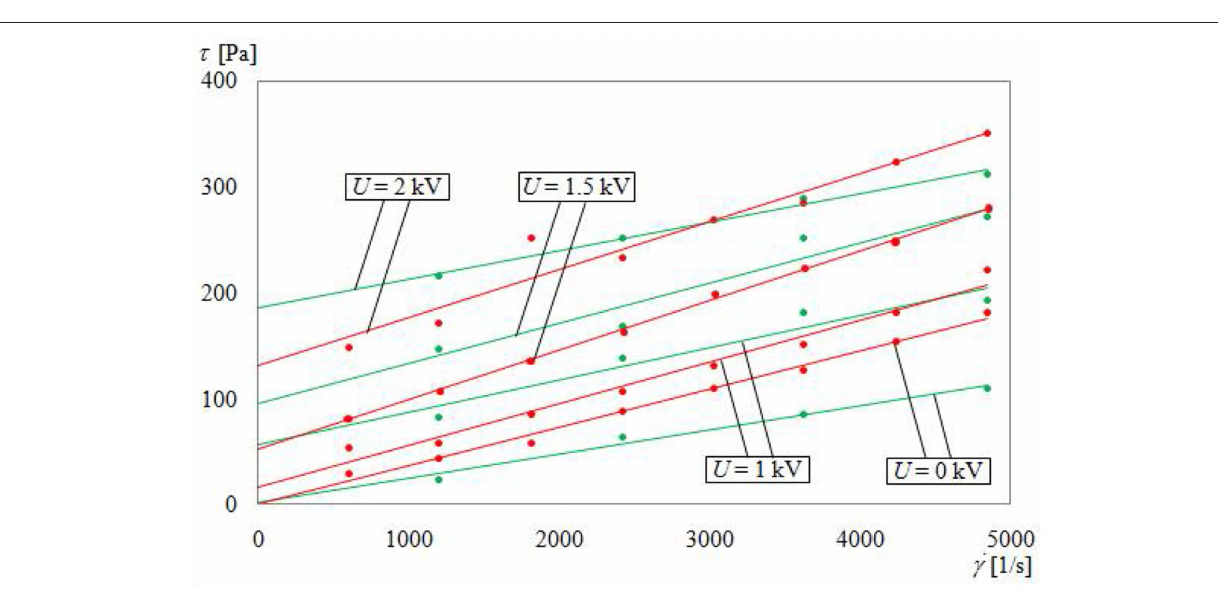
FIGURE 9 | Dependence of τ from ˙ γ for T = 20 ◦ C and w = 30%: green color, measurement devices; red color, viscous clutch with ER